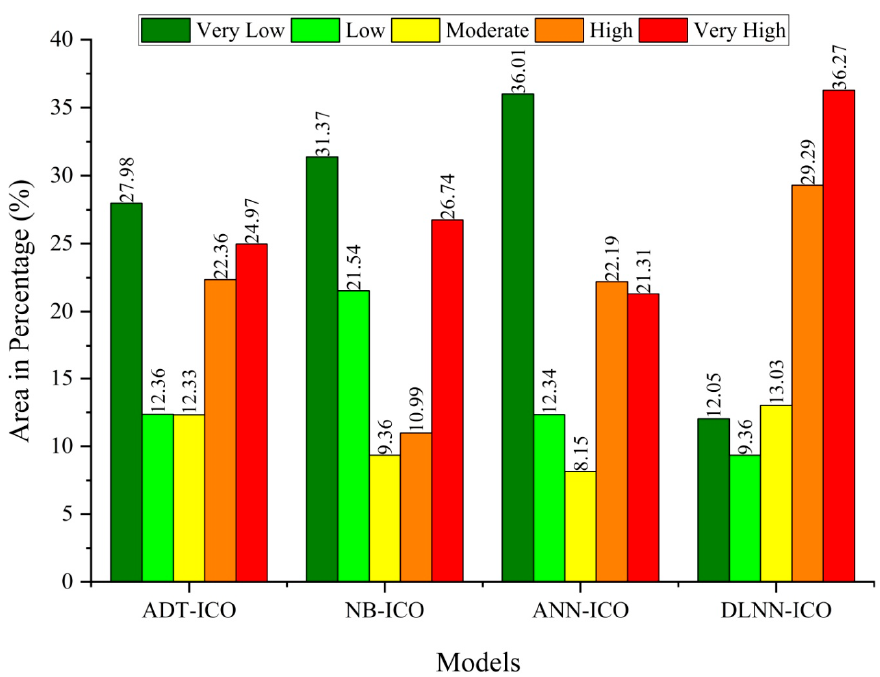
Figure 5. Areal percentage of different flood susceptibility classes.